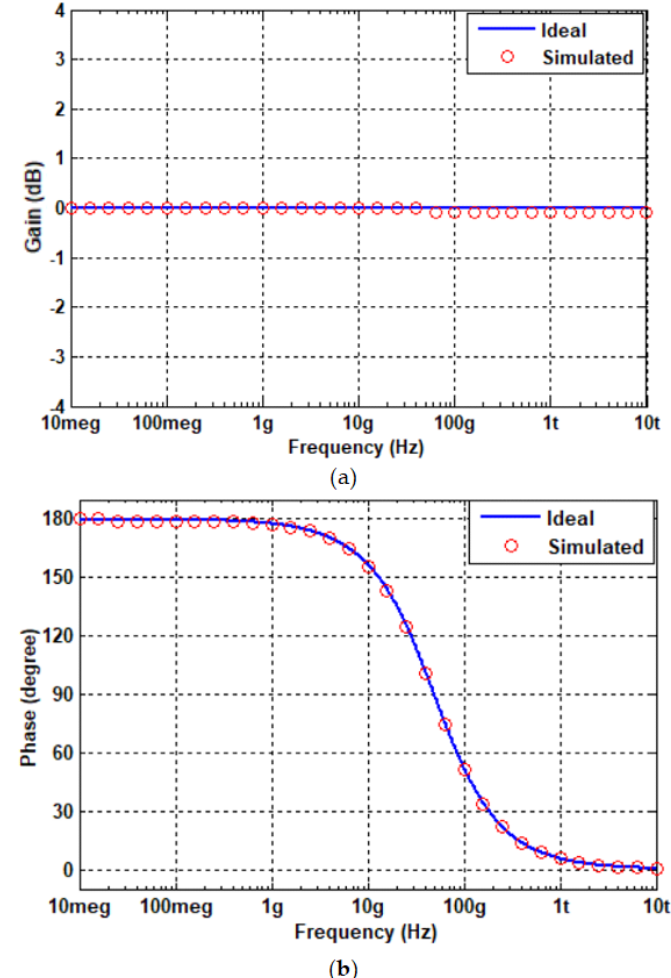
Figure 11. Ideal and simulated frequency-response of AOTAPF at V tune = − 0.32 V: ( a ) Voltage gain; ( b ) Phase.